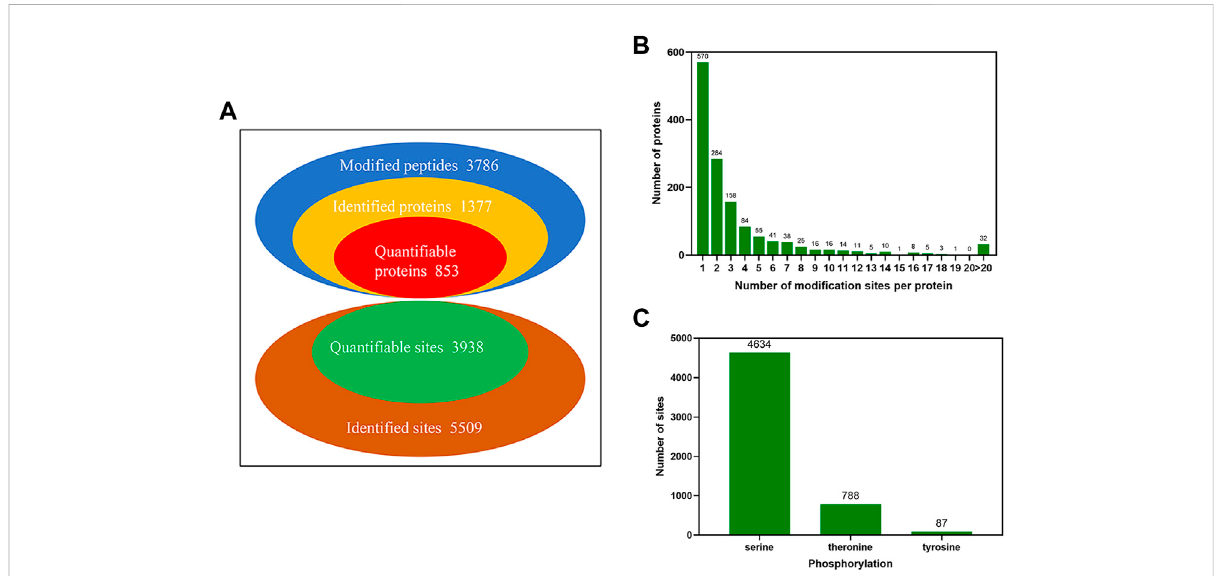
The identi fi cation of global phosphorylated proteins and their sites in yak sperm. (A) The identi fi cation and quanti fi cation of phosphorylated proteins and sites. (B) The number distribution of phosphorylation modi fi cation sites of phosphorylated proteins. (C) The phosphorylation site distribution of serine, threonine and